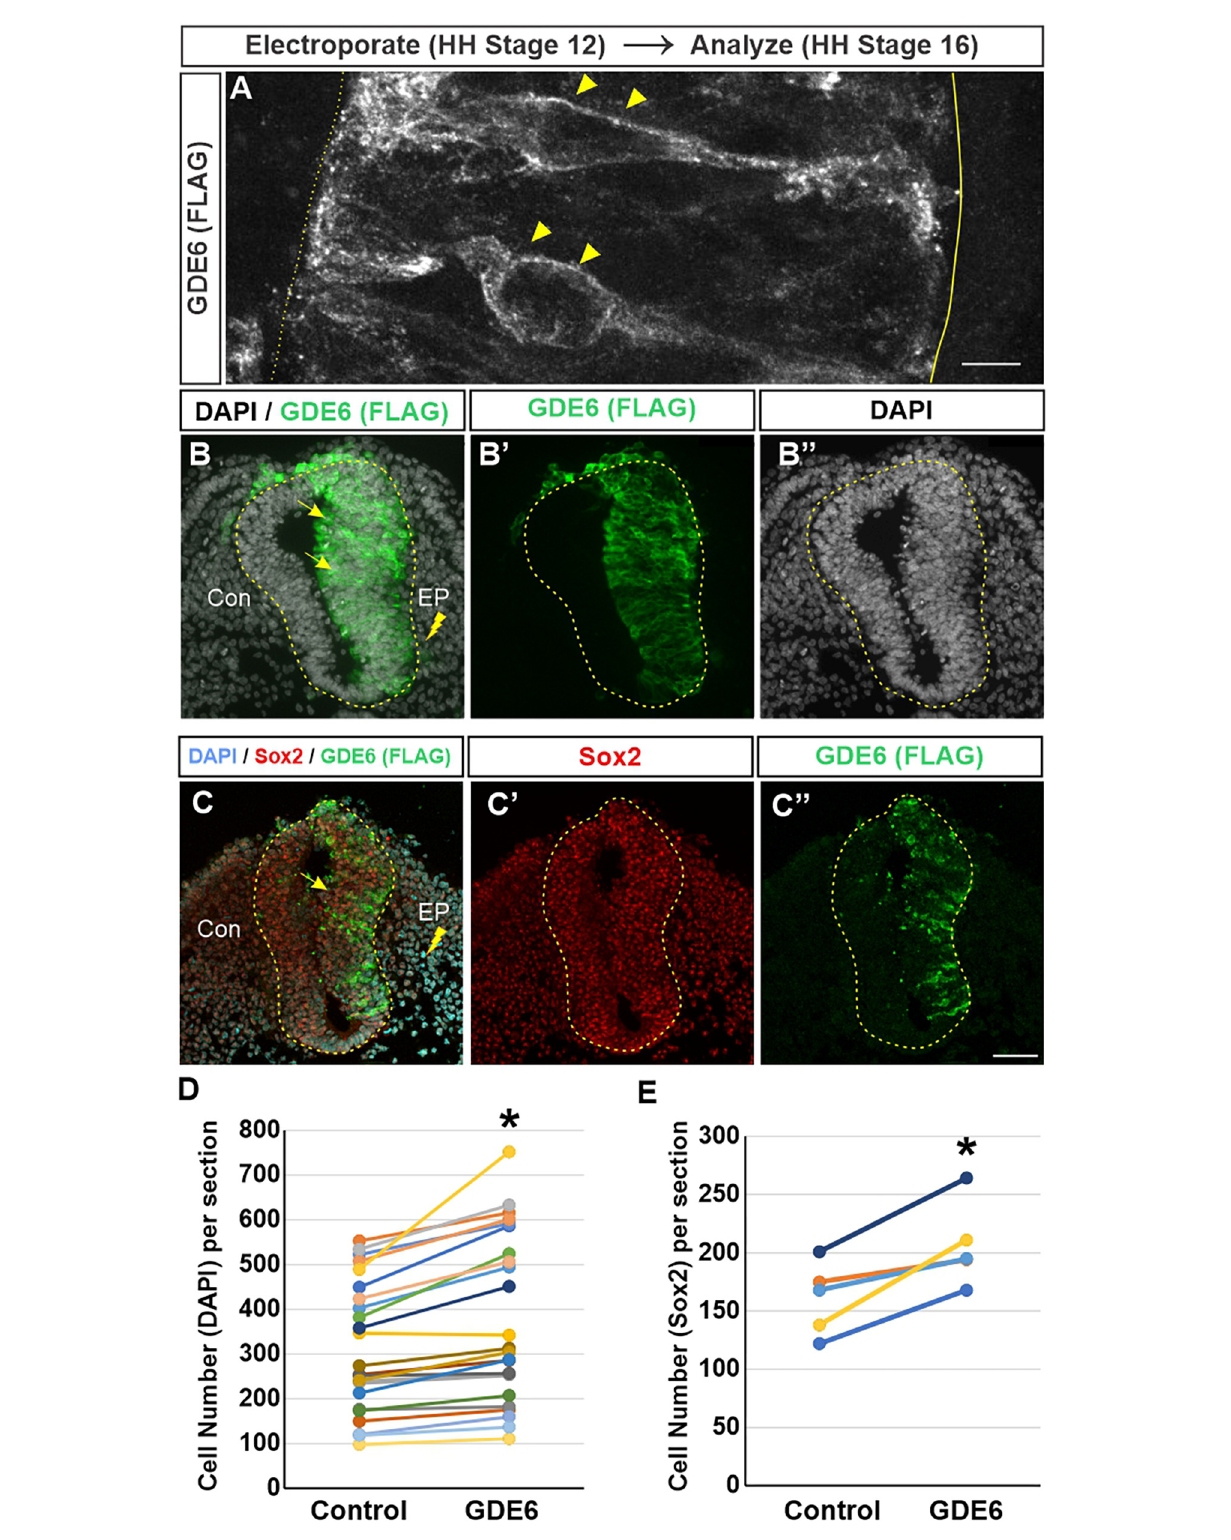
FIGURE2 GDE6 overexpression induces neural tube hyperplasia. (A–C”) Transverse sections of stage 16 neural tube electroporated at Stage 12 with Flag-tagged GDE6. Anti-flag staining shows GDE6 expression in electroporated cells. (A) 63X confocal rendering of individual radial glia cells in the neurepithelium. GDE6 exhibits a membrane bound localization on the cell surface (arrowheads). Dotted line denotes the ventricular surface, solid line is the pial surface. (B–C”) Arrows denote the hyperplasia on the electroporated side (EP) compared to the control side (Con). DAPI labels all cell nuclei and Sox2 marks progenitors. (B,C) Are different embryos. (D) Quantification of neural tube cell number. Paired two-tailed t -test, * p < 0.001, n = 28. (E) Quantification of Sox2 + progenitors. Paired two-tailed t -test, * p = 0.011, n = 5. Scale bar (A) = 5 µ m. Scale bar (B–C’) = 40 µ